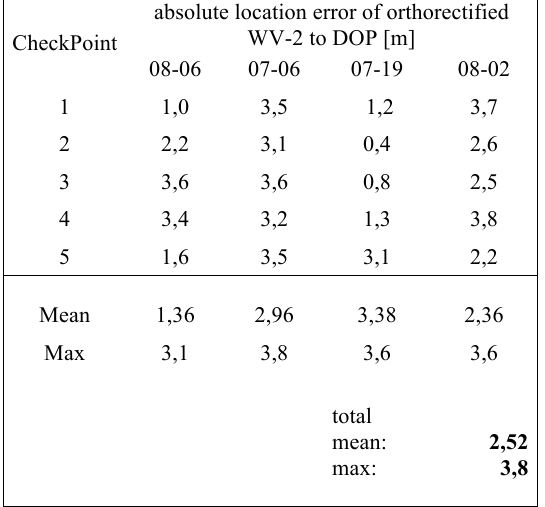
Table 1. Absolute positional error of the WorldView-2 images.